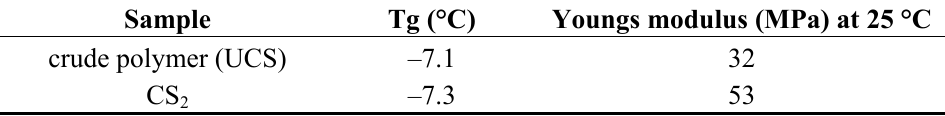
Table 1. Glass transition temperatures and Youngs modulus.